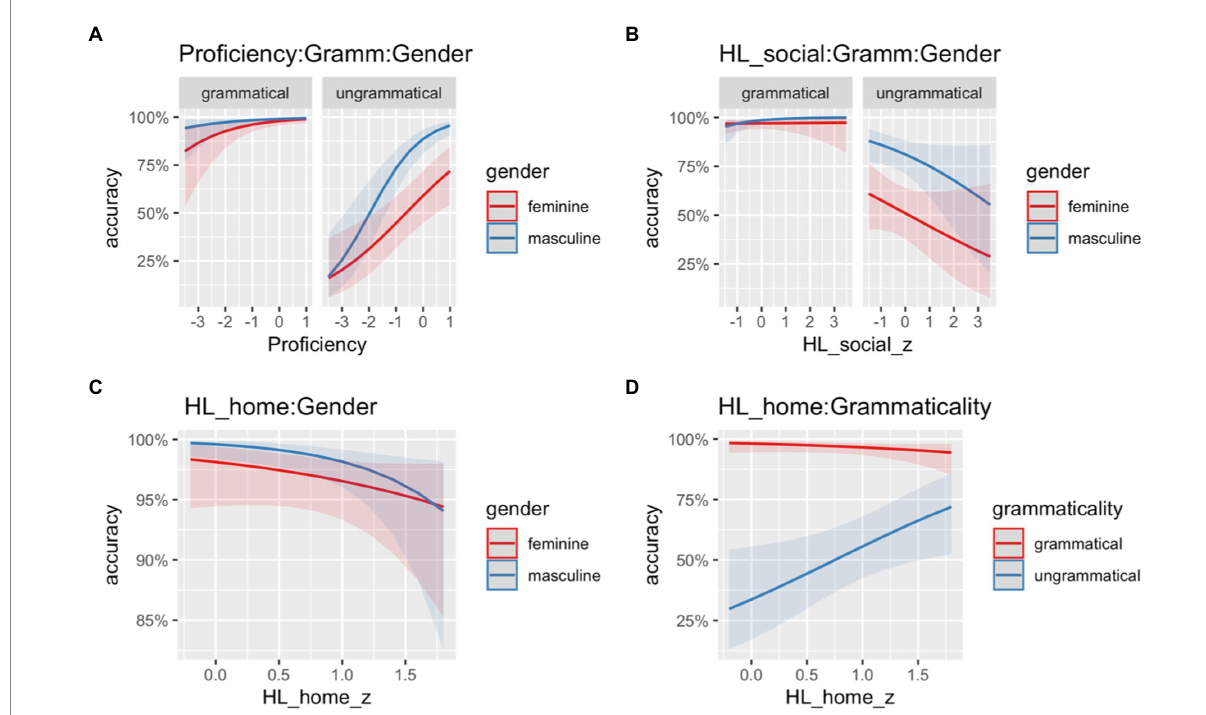
FIGURE 6 (A) Illustration of the three-way interaction between Proficiency , Grammaticality (grammatical, ungrammatical), and Gender (feminine, masculine); (B) Illustration of the three-way interaction between heritage exposure outside of home context (HL_social), Grammaticality (grammatical, ungrammatical), and Gender (feminine, masculine); (C) Illustration of the two-way interaction between heritage exposure at home (HL_home) and Gender (feminine, masculine); and (D) Illustration of the two-way interaction between heritage exposure at home (HL_home) and Grammaticality (grammatical,